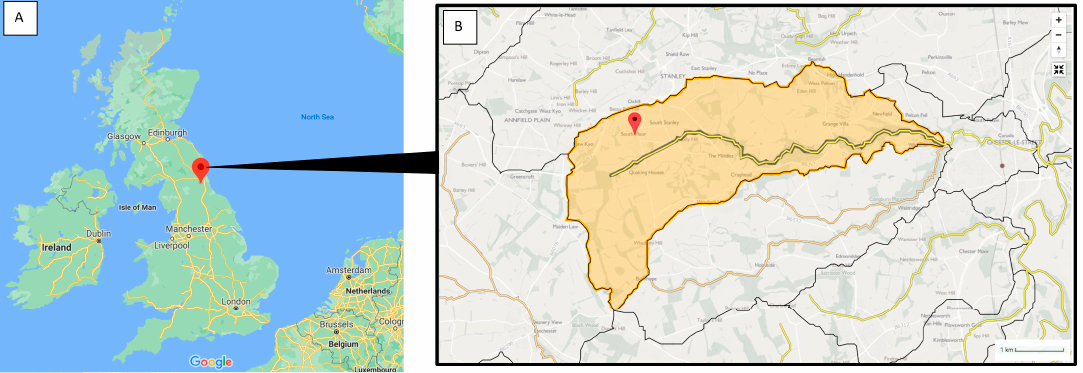
Figure 2. Location of the study area (shown by red pin): ( A ) in the United Kingdom [36] and; ( B ) within the Twizell Burn catchment [34].